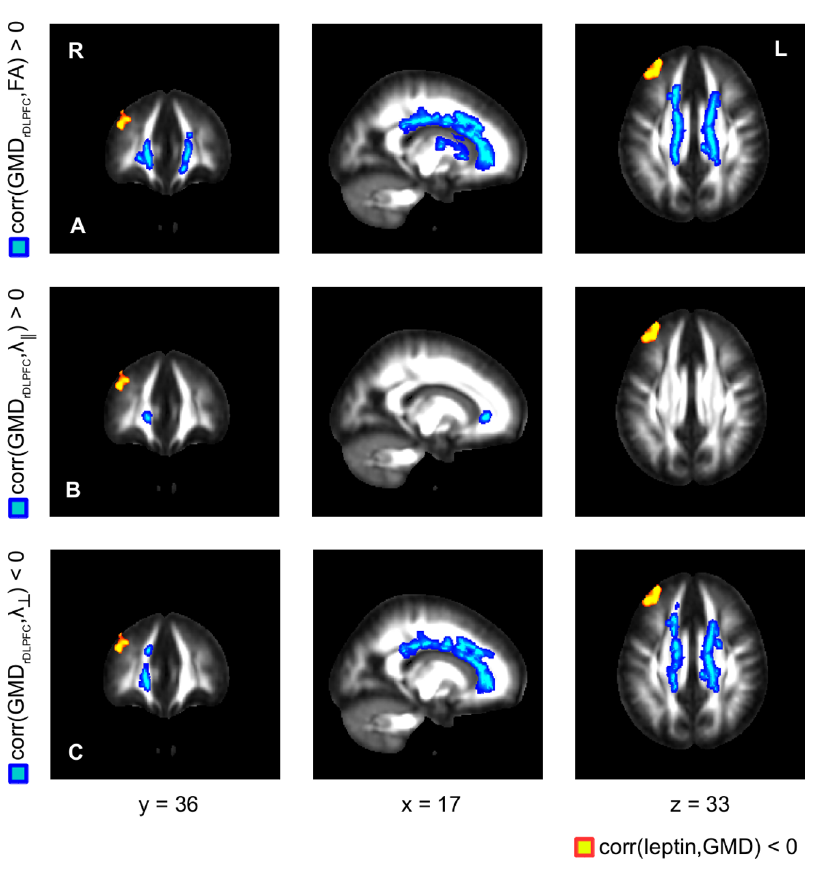
Figure 1. Correlation between GMD rDLPFC and diffusion parameters. Voxel-based morphometry yielded a negative correlation between GMD and the serum leptin level in the right DLPFC (color-coded in red/yellow, p , 0.001). Using randomization tests, a significant positive correlation was found between GMD rDLPFC and FA in the corpus callosum ( A ; color-coded in blue, p , 0.05, corrected). Inspection of the diffusion tensor elements ( B, C ) indicated that the decreased FA observed for a decreased GMD rDLPFC predominantly resulted from an increased l H ( C ; negative correlation between l H and GMD rDLPFC , p , 0.05, corrected), whereas indications of decreased l || were limited to a small region in the genu of the corpus callosum ( B ; positive correlation between l || and GMD rDLPFC , p , 0.05, corrected). No significant correlation was observed between GMD rDLPFC changes and